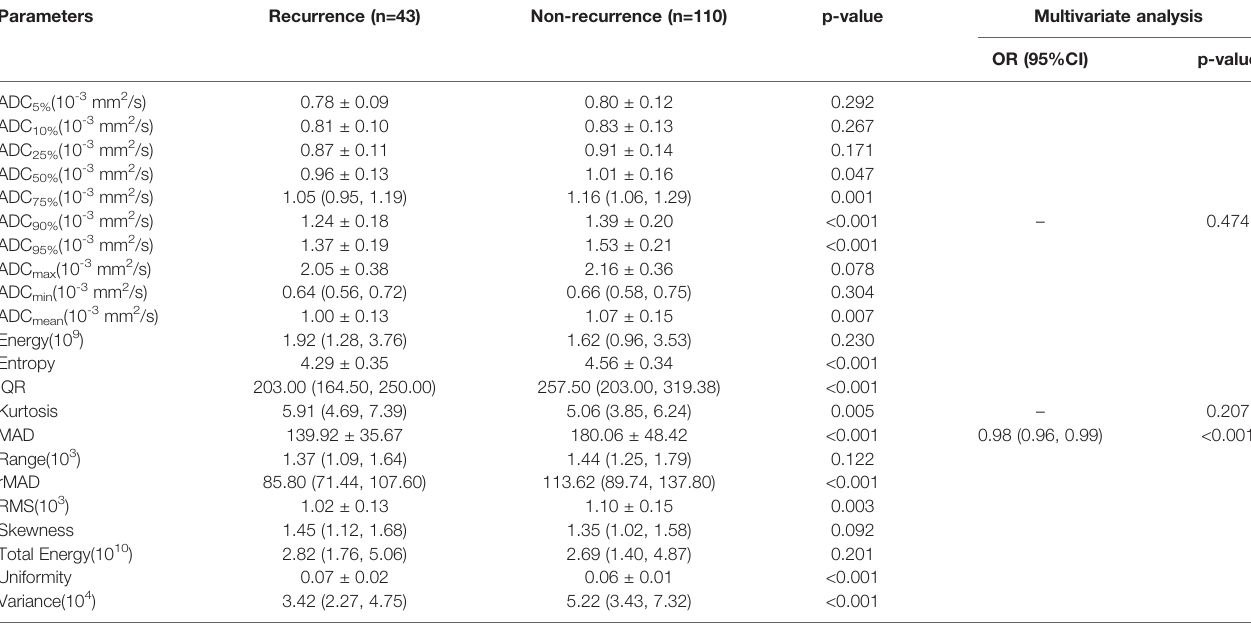
TABLE 4 | Comparison of fi rst-order texture features between recurrence and non-recurrence group in the training cohort. Parameters